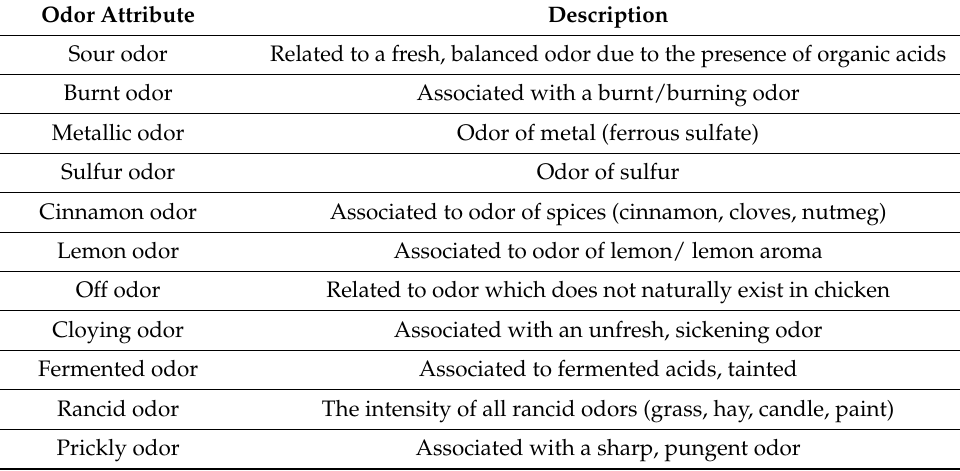
Table 2. Definition of sensory attributes used in sensory profiling of raw